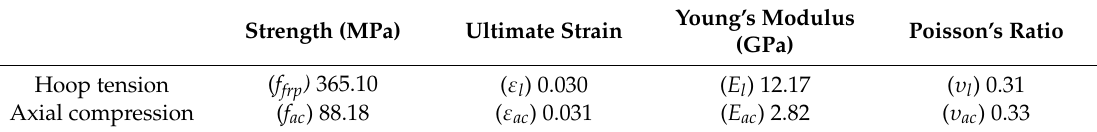
Table 2. Material properties of the GFRP tubes.